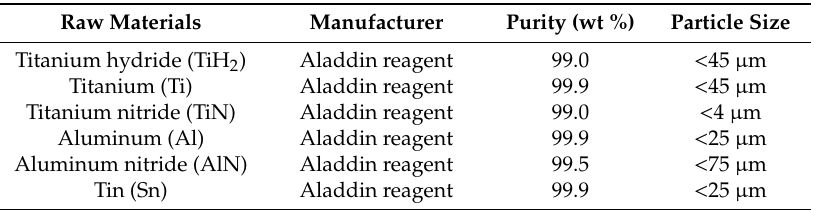
Table 1. Technical features of the raw